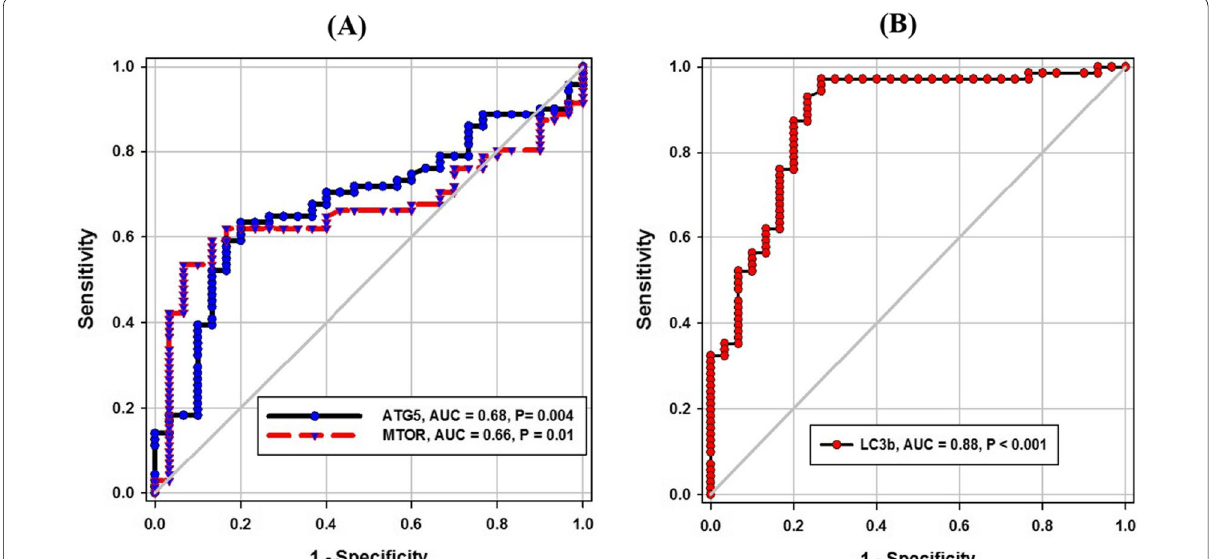
Fig. 2 ROC curve of A ATG5 , mTOR , and B LC3b